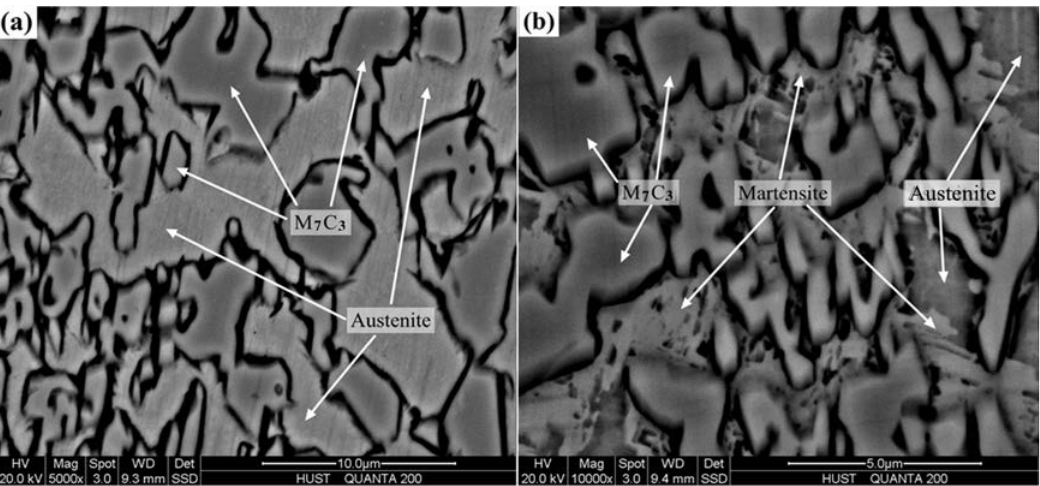
Figure 8. Microstructure of eutectic zone of HCCI hardfacing layer, ( a ) 3.6C-20Cr-Fe, ( b ) 3.6C-20Cr- Fe-1.50V.